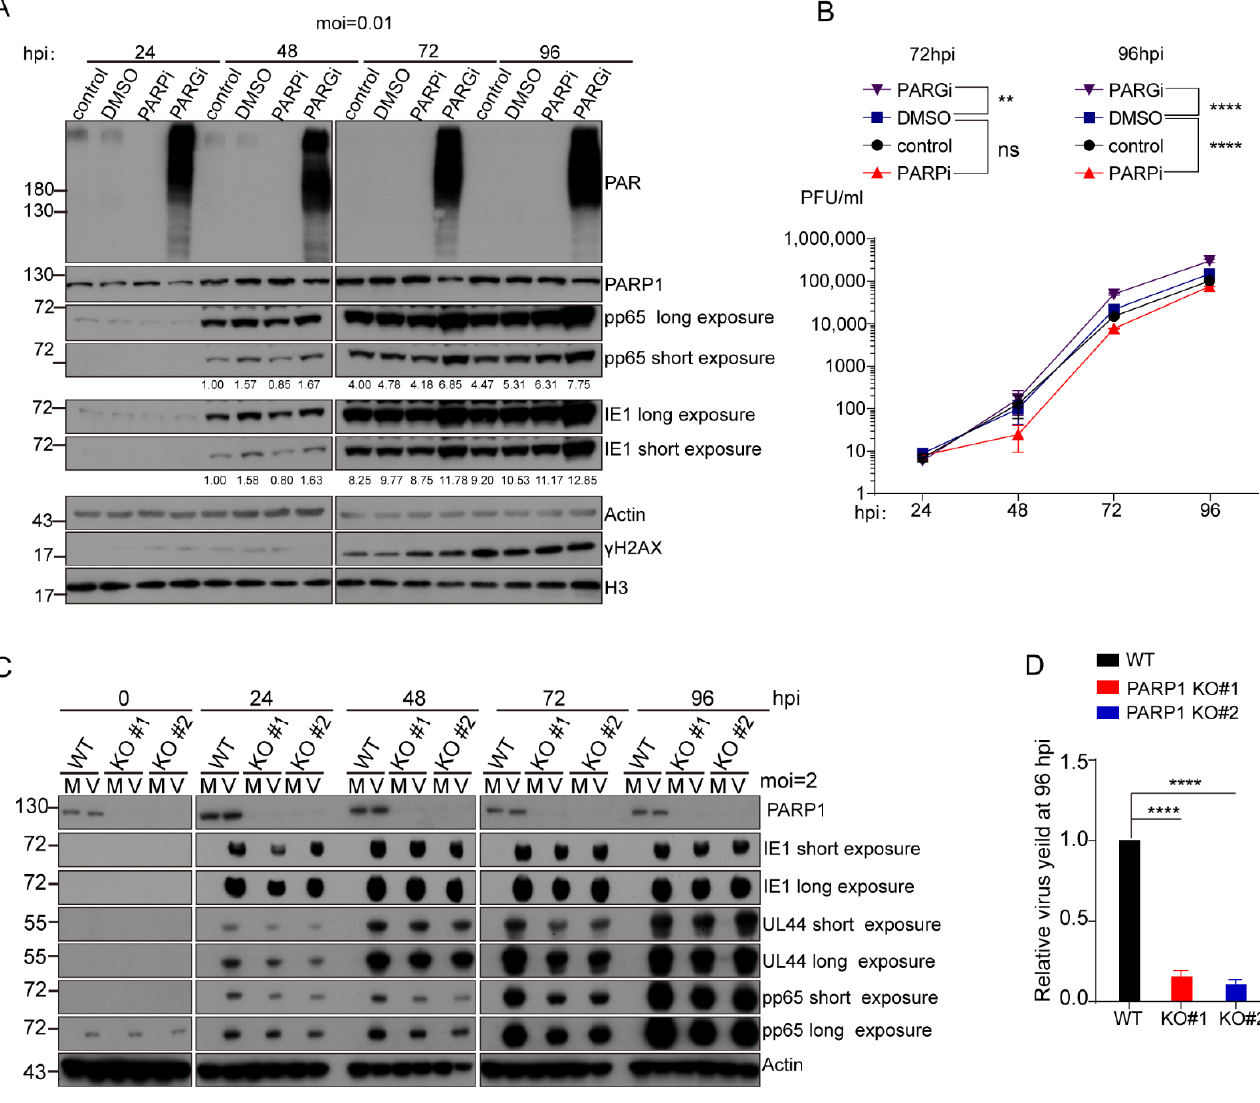
Figure 1. PARP-1 and its enzymatic activity were required for efficient HCMV replication in fibroblast. ( A ) MRC-5 cells were infected with HCMV at an MOI of 0.01. After 1 h adsorption, the virus was removed, and cells were washed with PBS. Fresh medium containing DMSO, 10 µM Olaparib or 10 µM PARG inhibitor was added to the cells and inhibitors were replenished every 24 h. Cells were collected every 24 h and cell lysates were analyzed by immunoblotting using indicated antibodies. IE1 and pp65 levels relative to those in control group at 48 h were quantified by Image J and values were presented below each blot. ( B ) Multistep growth curves of HCMV in PARPi or PARGi-treated MRC-5 cells. MRC-5 cells were infected and treated as panel ( A ). Released virus in the supernatant were collected and virus titers were determined by standard plaque-formation assay. The mean values are shown with bars denoting standard deviations for two independent experiments. ** p < 0.01, **** p < 0.0001. ( C ) PARP-1 depletion attenuates HCMV replication in immortalized Human Foreskin Fibroblasts (HFFs-hTERT). Wild type and two independent PARP-1 deficient HFFs-hTERT cell lines were mock infected (M) or infected with HCMV (V) at an MOI of 2. Cells were collected every 24 h and analyzed by immunoblotting with the indicated antibodies. ( D ) Progeny virus released to the culture at 96 hpi were collected and virus titers were analyzed by standard plaque formation assay. Values represent viral yields at 96 hpi and are expressed relative to WT HFFs-hTERT. Shown is the average of triplicate biological experiments ( ± 1 SD), **** p <